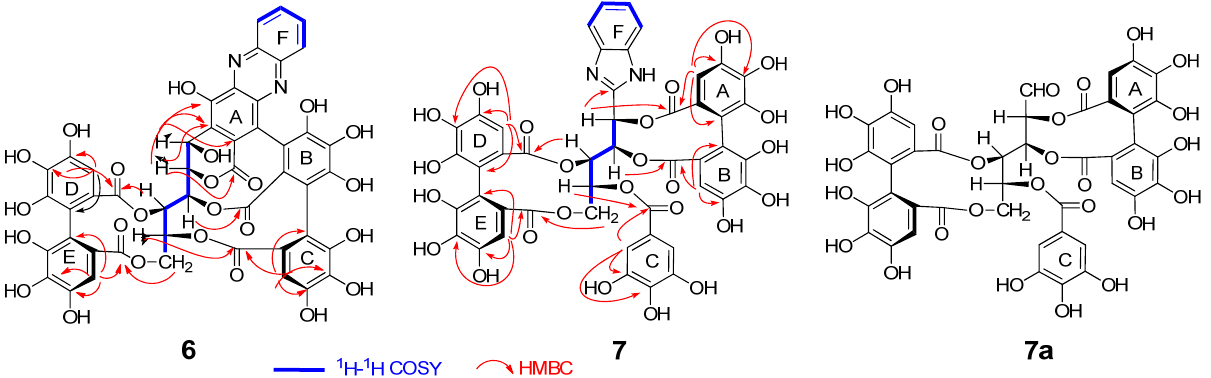
Figure 4. Selected 1 H– 1 H COSY and HMBC correlations of 6 and 7 and structure of liquidambin ( 7a ).